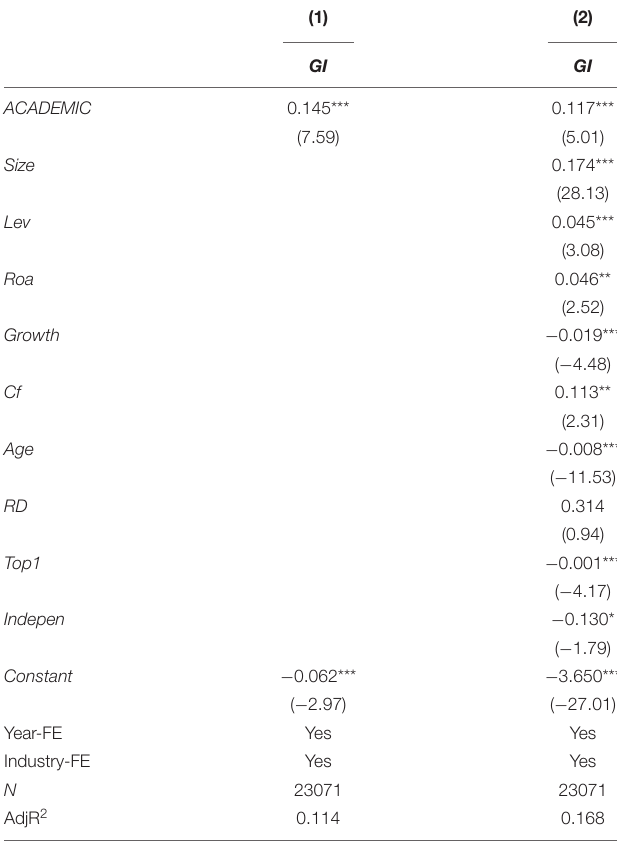
TABLE 5 | Association between executives with academic experience and green